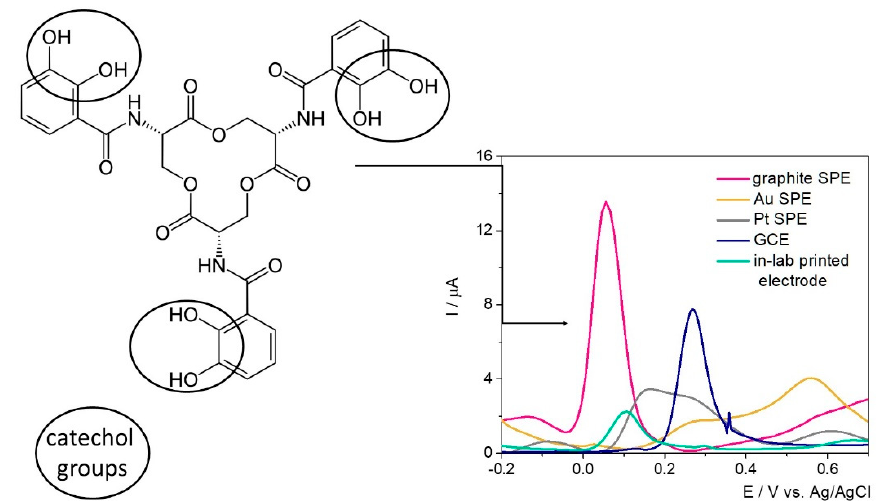
Figure 1. Ent structure and the electrochemical oxidation on different electrode materials.